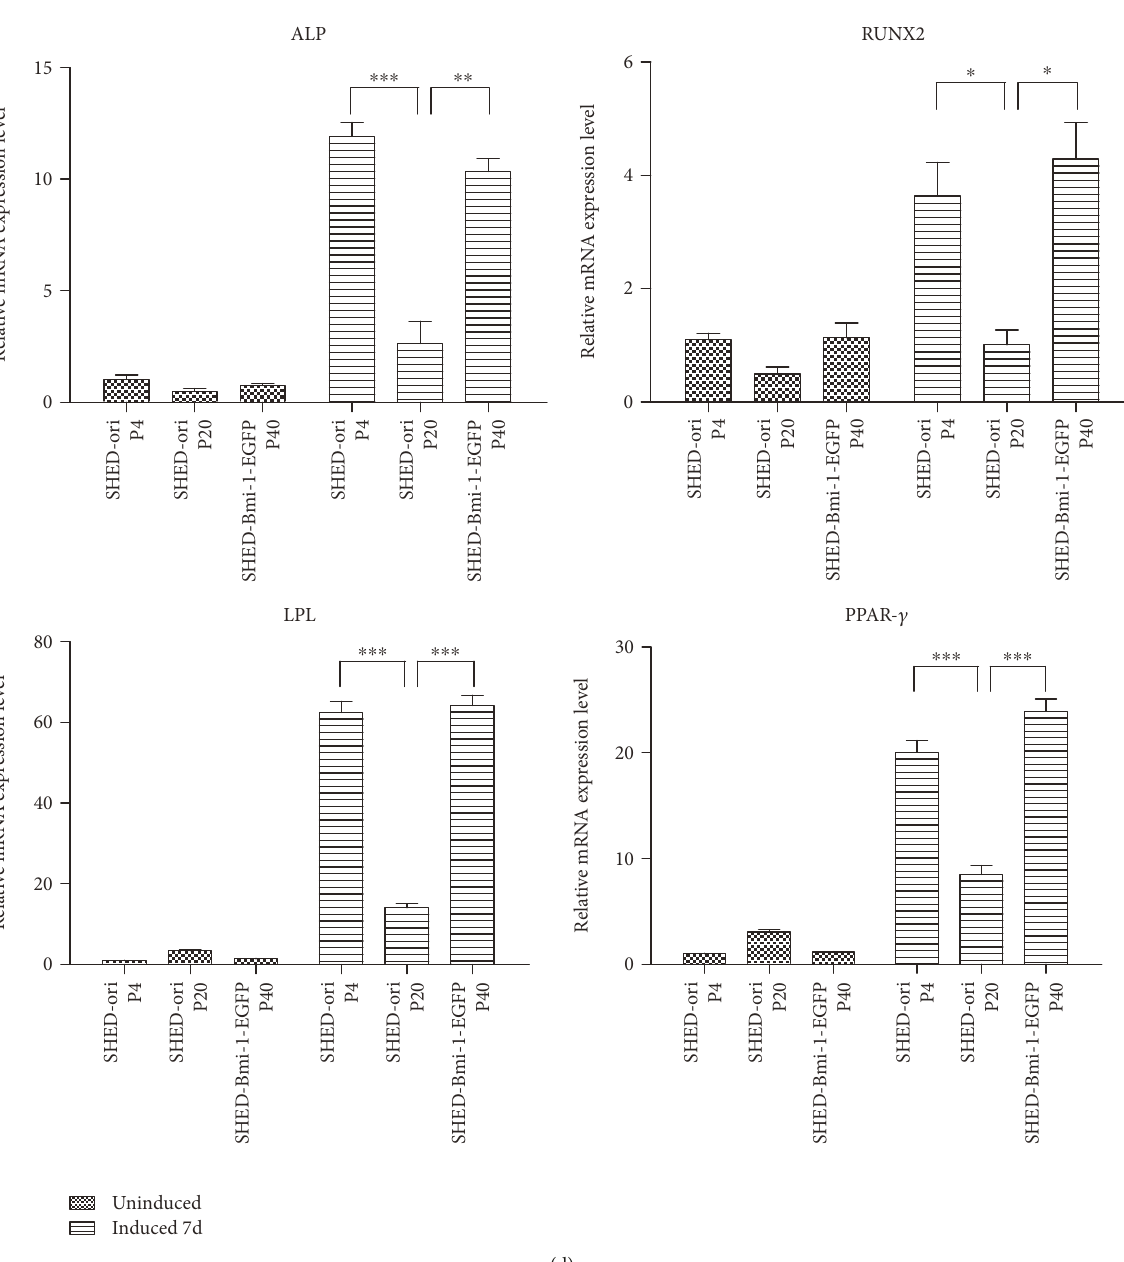
Figure 3: Multilineage di ff erentiation assay of SHED-ori P4, SHED-ori P20, and SHED-Bmi1-EGFP P40. (a) Alizarin Red staining was performed to evaluate the osteogenic di ff erentiation ability of the cells, and the semiquantitative results were calculated. (b) ALP staining and ALP activity assays were performed both in SHED-ori P4, SHED-ori P20, and SHED-Bmi1-EGFP P40. (c) Adipose droplets in cells were stained orange by Oil Red O after 21 days of adipogenic di ff erentiation induction, and the semiquantitative results were calculated. (d) Osteogenic and adipogenic di ff erentiation related genes were detected by qRT-PCR. Scale bar, 200 μ m. Data are shown as the mean ± SDs of 3 separate experiments. ∗ P < 0 05 , ∗∗ P < 0 01 , and ∗∗∗ P < 0